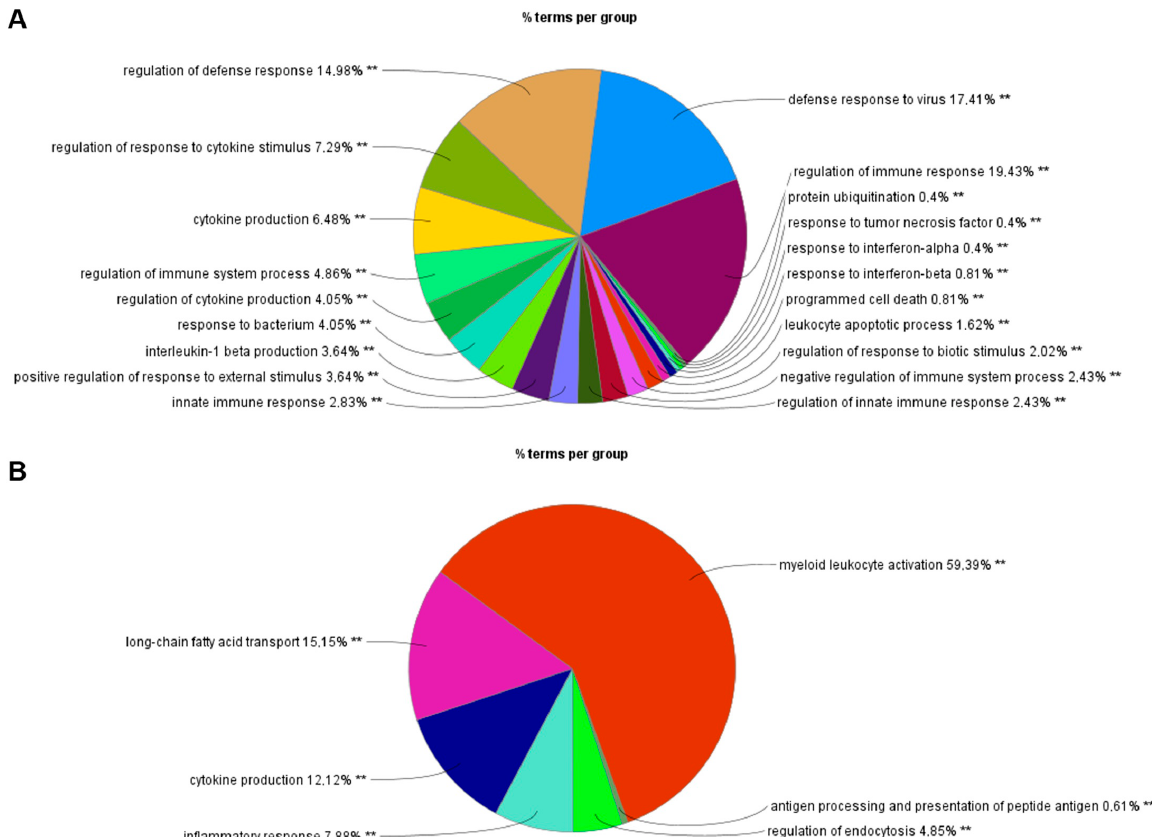
Figure A4. Functional analysis of DEGs identified by RNA-Seq on Cytoscape using the plug-in ClueGO. Functions of DEGs upregulated ( A ) and downregulated ( B ) by I-TBEV treatment. ** indicates a p -value < 0.01.